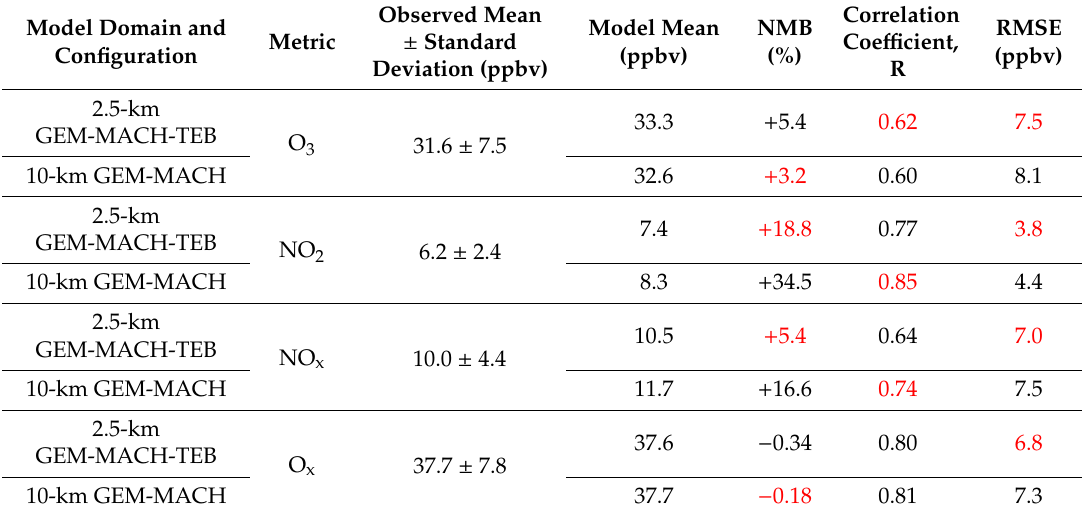
Table 2. Comparison of 10-km GEM-MACH with 2.5-km GEM-MACH-TEB for 1-h data in July 2015 from all the Canadian sites in the 2.5-km domain (O 3 data is also included from U.S. AQS network). Values in red font denote better scores between the two model